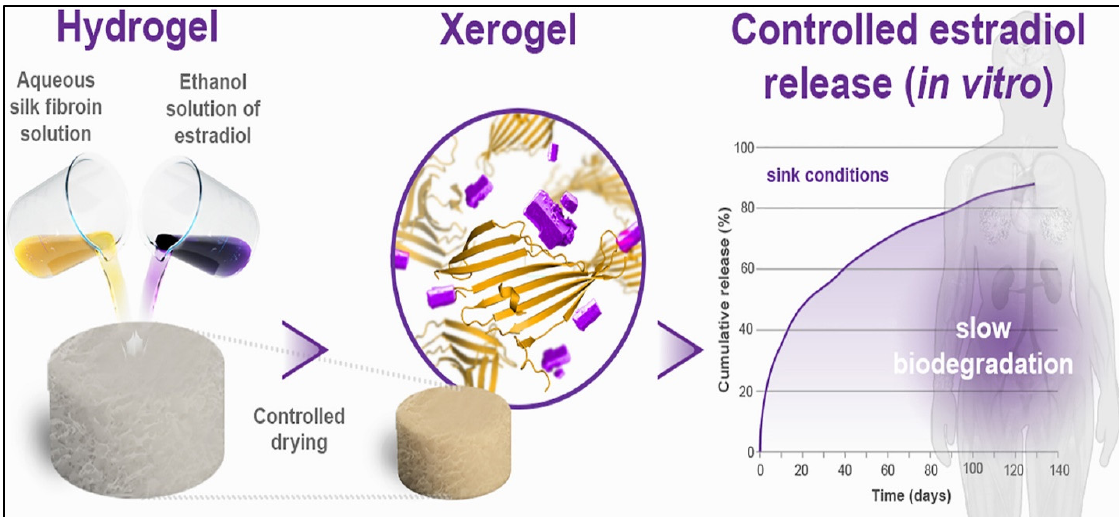
Figure 3. Illustration of silk fibroin based xerogels in controlled release of estradiol drug. Adapted from Križman et al. [63] with permission from Elsevier, 2022.